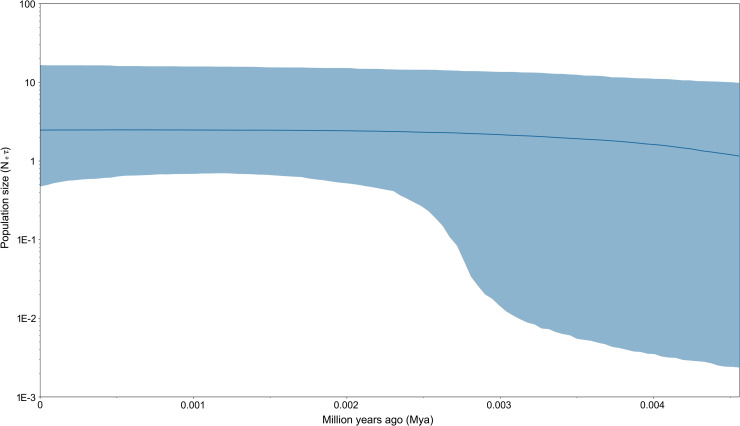
Bayesian skyline.Bayesian skyline plot of changes of effective population size through time for Rhinogobius gigas.